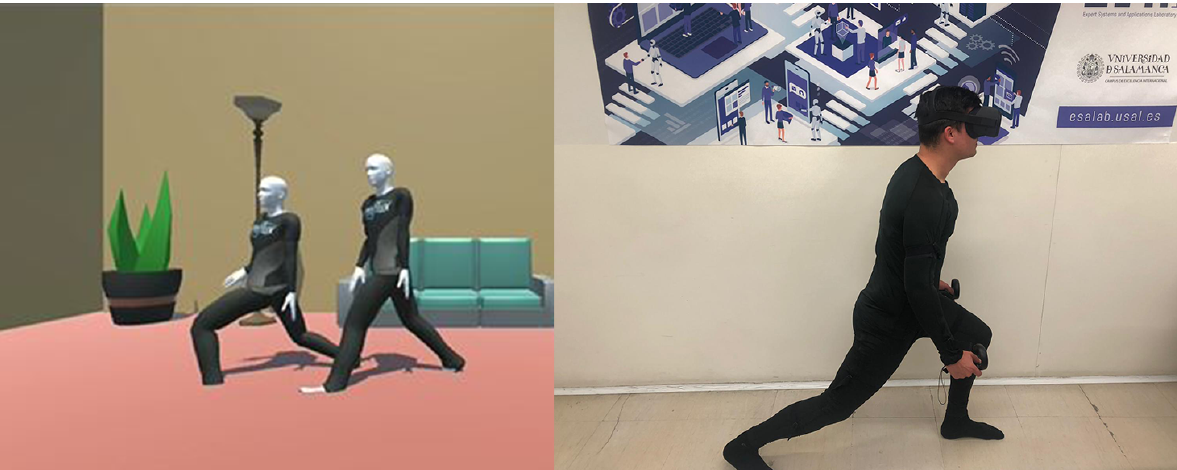
Figure 11. User doing exercise.